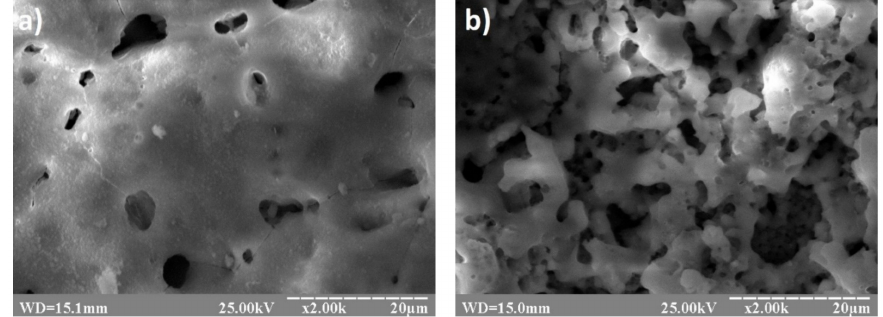
Figure 5. Surface morphology of the two anodized layers, shown in Figure 4, obtained on Ti-15Mo in the electrolytes of series 9 ( a ) and series 10 ( b